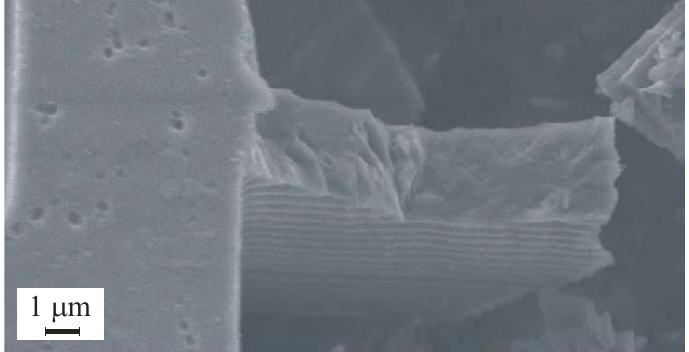
Figure 1. Detail of a shock-induced failure of a suspension spring of a polysilicon MEMS.